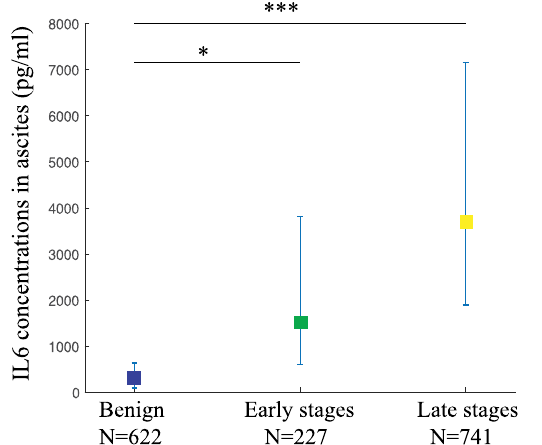
Figure 2. The circulating IL6 levels are higher in various OC stages compared to the healthy controls. IL6 levels in serum/plasma from OC and controls are depicted as pooled weighted means ± 95% CI. Multiple comparison analysis was performed by Tukey test. * p -value < 0.05, ** p -value < 0.01.